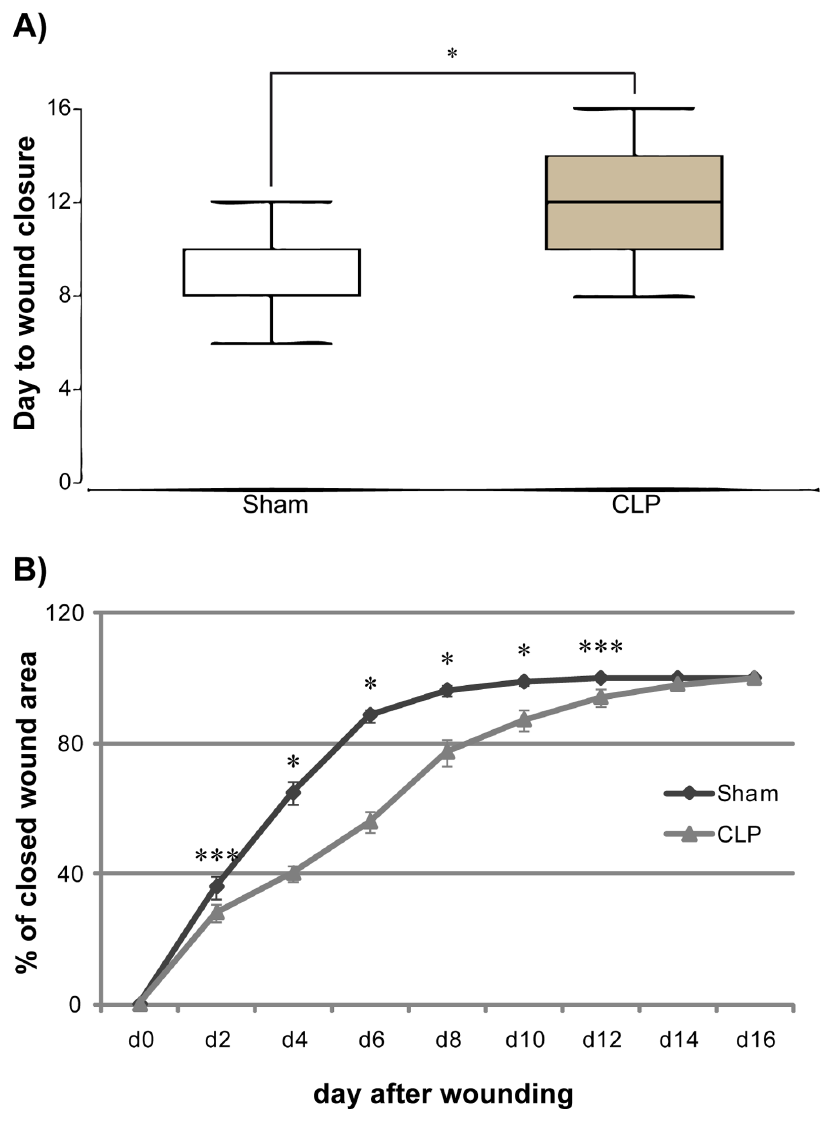
Figure 2. Delay of wound closure and epithelialization in septic animals. A. Day of wound closure. Animals that underwent CLP procedure exhibit a highly significant delay in day of wound closure (Data is shown as box plots of the median, n =10). B. Percentage of closed wound area on day 0–16 (measured every second day). Septic mice have a highly significant delay in epithelialization as there is a decrease in percentage of closed wound area from day 2 to day 12 after wounding. (Data is shown as mean 6 SD, n =10). * p , 0,001, *** p ,